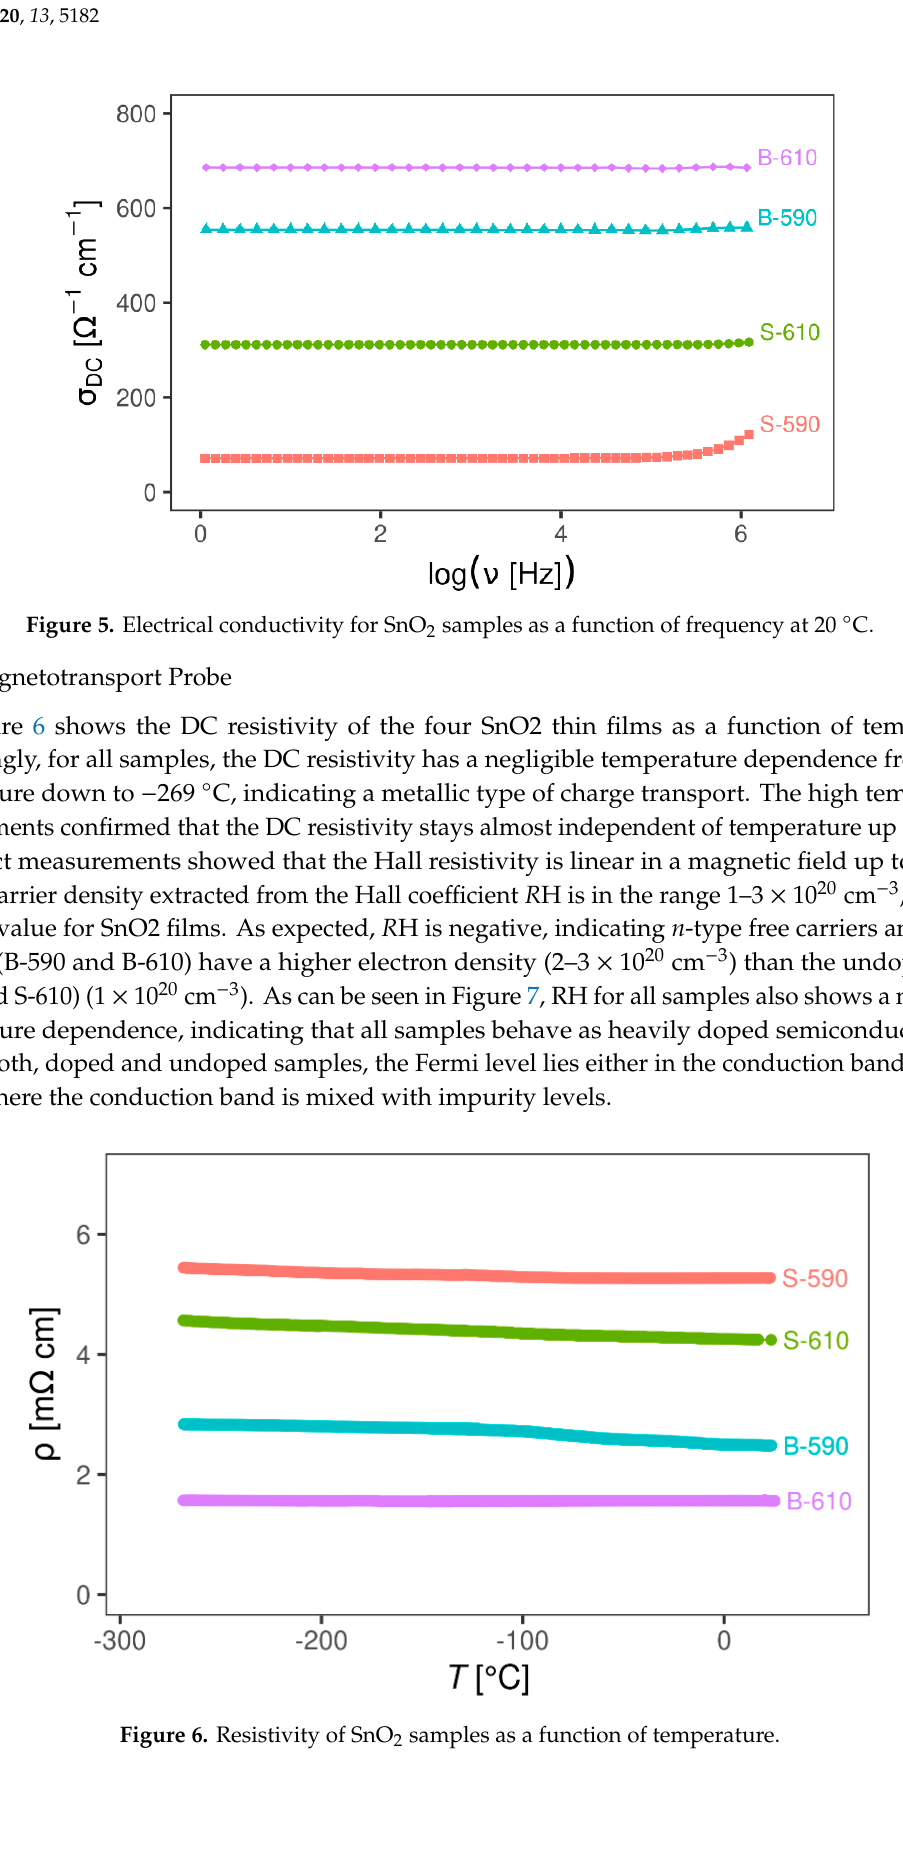
Figure 6. Resistivity of SnO 2 samples as a function of temperature.